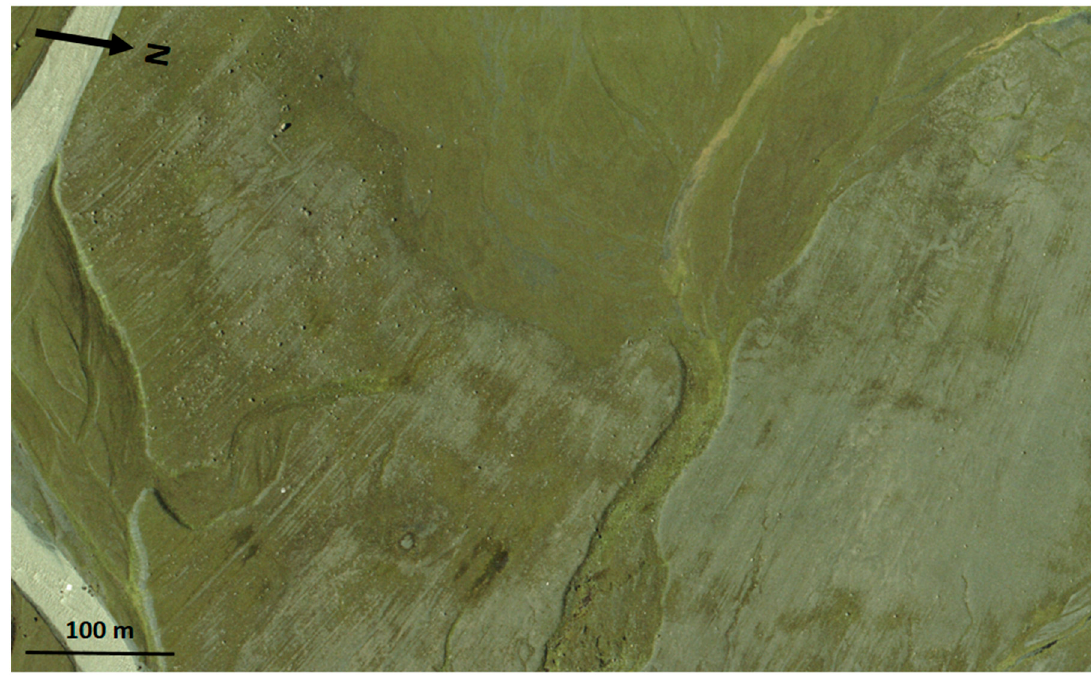
Figure 8. Aerial photograph extract (NERC ARSF 2007) showing the fluted surface with scattered boulders and occasional stoss boulders in the moraine-free area of the inner Sandfellsjökull foreland.